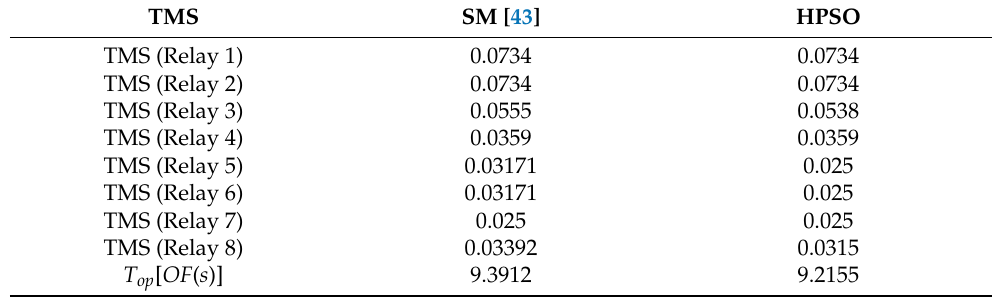
Table 9. Comparison of the optimized TMS with other techniques (case 3).